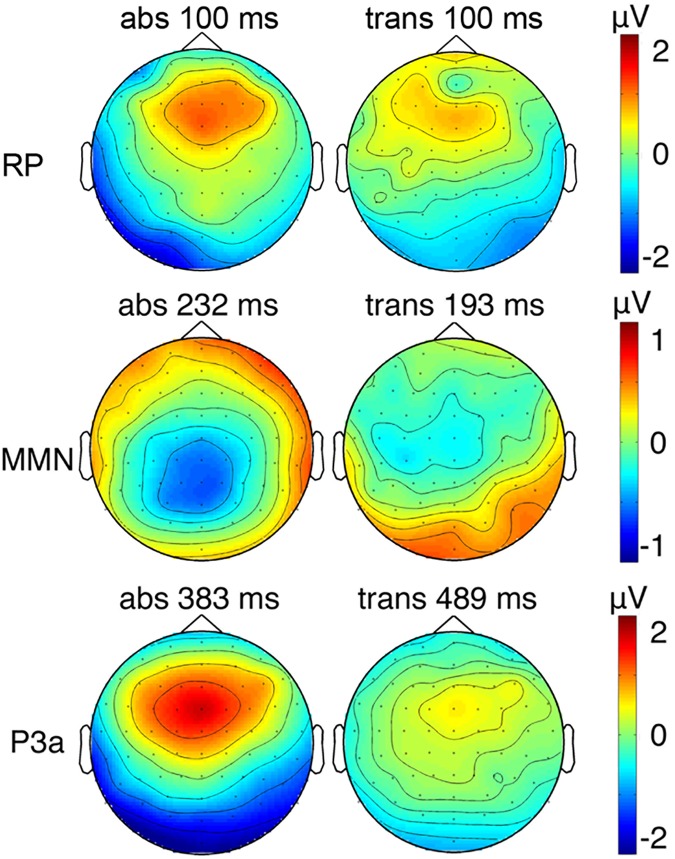
Scalp maps showing RP, MMN and P3a component distribution.Scalp maps are shown at time points with maximal deflections for MMN (top row) and P3a (bottom row) for the absolute repetition condition (abs) and the transposed repetition condition (trans). For RP the differences between train-length 12 and train-length 1 are calculated. Except for the default v4 interpolation between the electrode positions, no additional smoothing (such as a spatial filter) was applied.